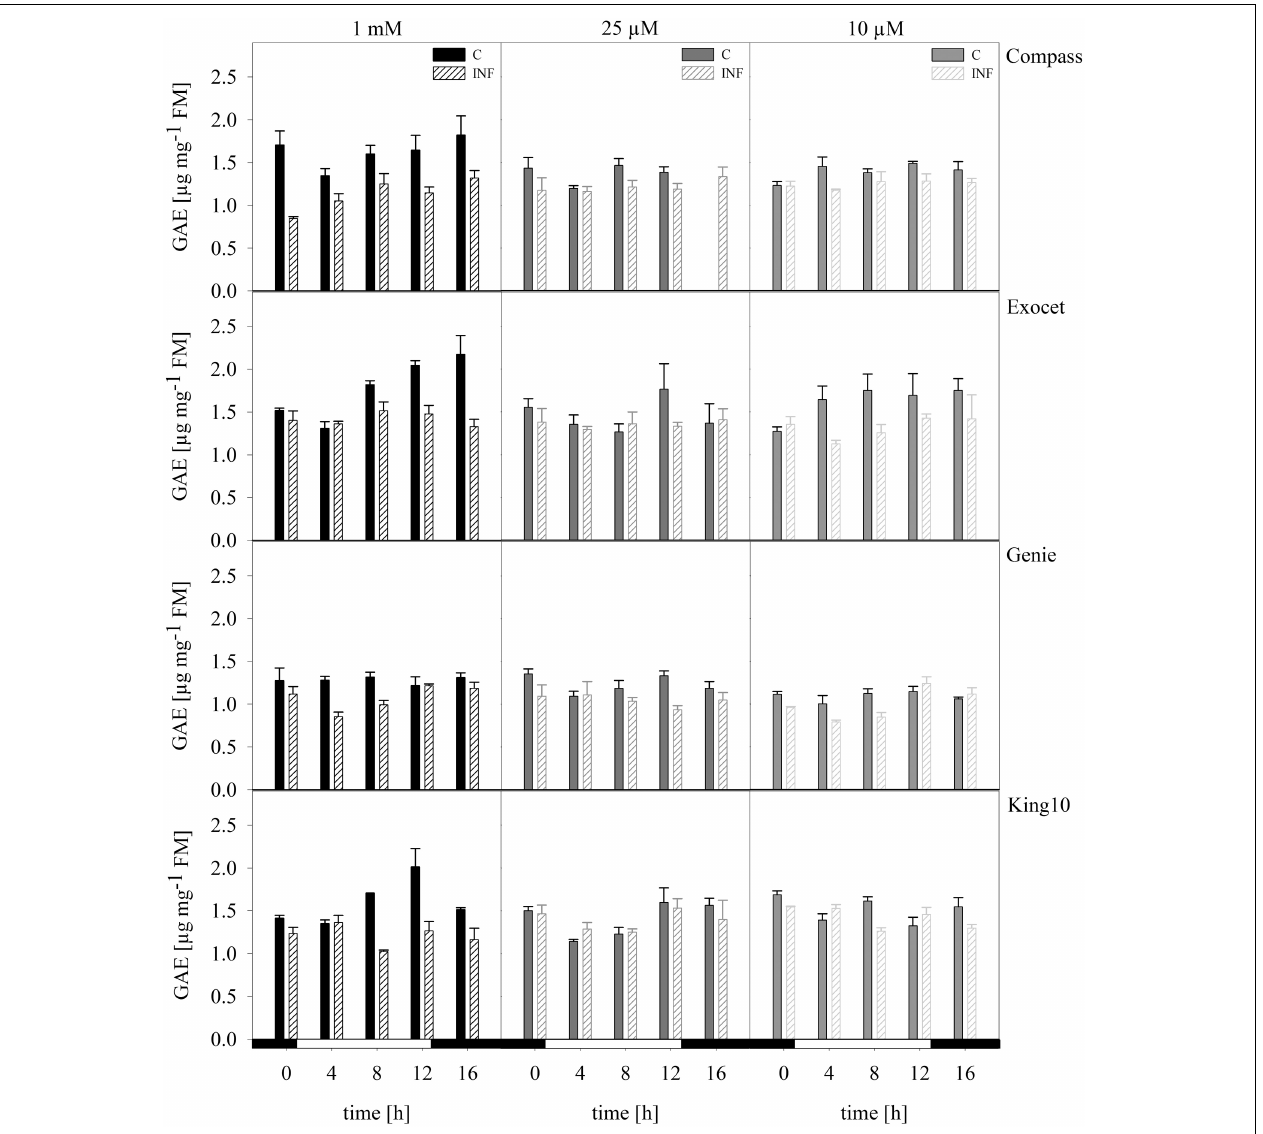
FIGURE 8 | Total phenols. The total phenol content was photometrically measured in plants with five leaves fully expanded of all cultivars. Plants for the measurement were treated and collected as described for Figure 5 . The results are shown in µ g g . − 1 FM as mean of three